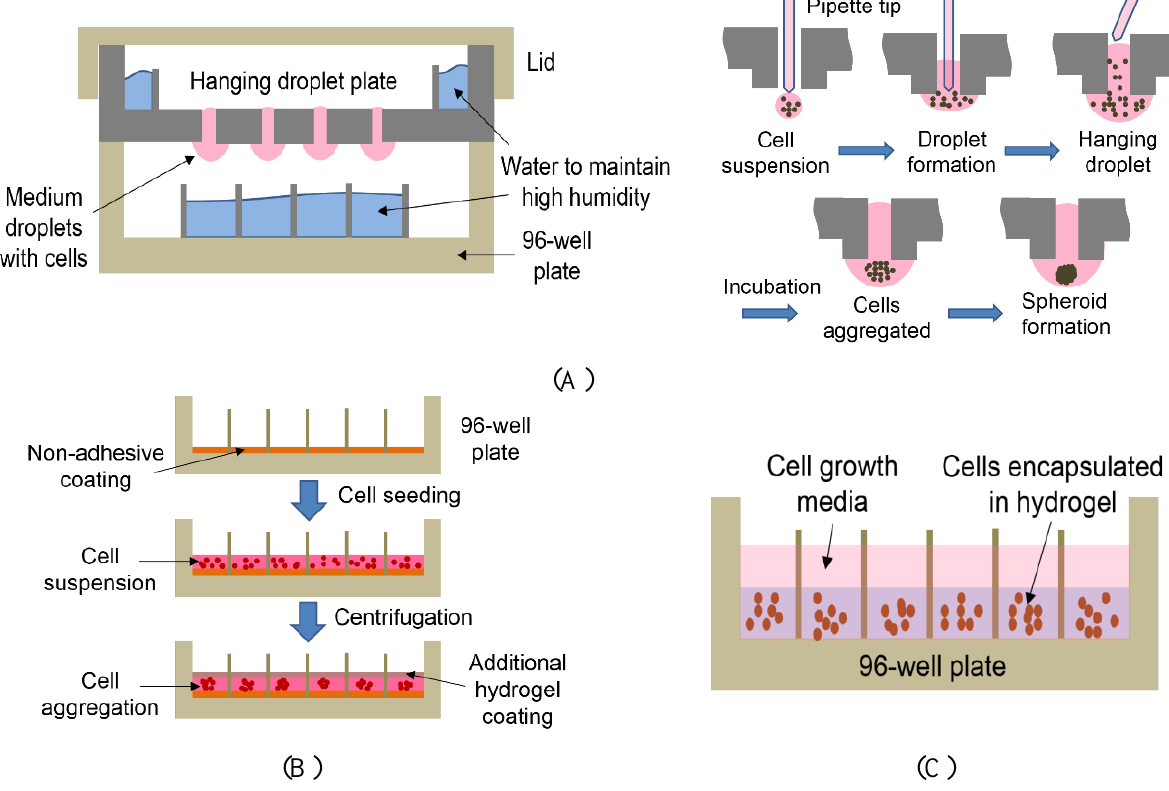
Figure 1. Commonly used 3D cell culture techniques for HCI. ( A ) Hanging droplet plate containing 3D spheroids. To generate 3D spheroids, cell suspension is dispensed through the access holes of the hanging droplet plate such that the droplets are attached to the hydrophilic surface. Individual cells are aggregated within hours of incubation due to gravity, forming a single spheroid. (Adapted from [57] with permission of The Royal Society of Chemistry.) ( B ) Liquid overlay on top of cells in a 96-well plate. The bottom of the 96-wells is coated with non-adhesive polymer in a serum-free medium, which is followed by cell seeding. The 96-well plate is centrifuged to induce cell aggregation and hydrogel in a serum-supplemented medium is overlaid on top of the aggregated cells. ( C ) Hydrogel matrix mixed with cells in a 96-well plate. Cell suspension is mixed with hydrogel and dispensed in the 96-well plate. Cells naturally form 3D structures within the hydrogel matrix while